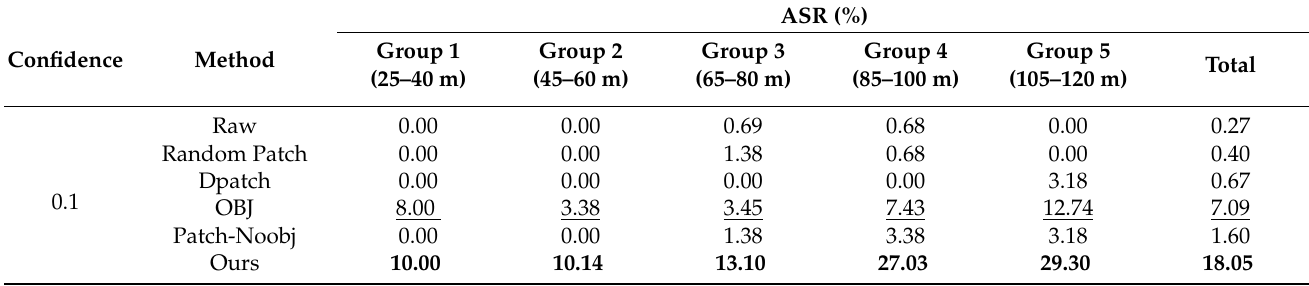
Table 2. Experimental results of different scales (25–120 m) and different confidence levels (0.1–0.6) for Yolo-V5. Specifically, the bold and underlined values indicate the best and the second